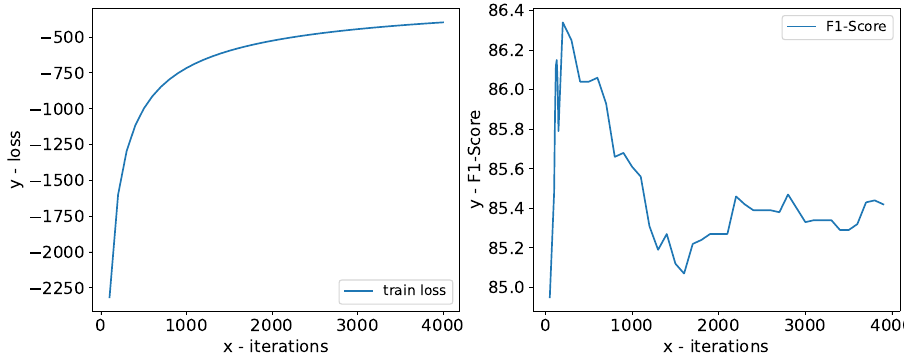
Figure 11. OpenNLP model learning